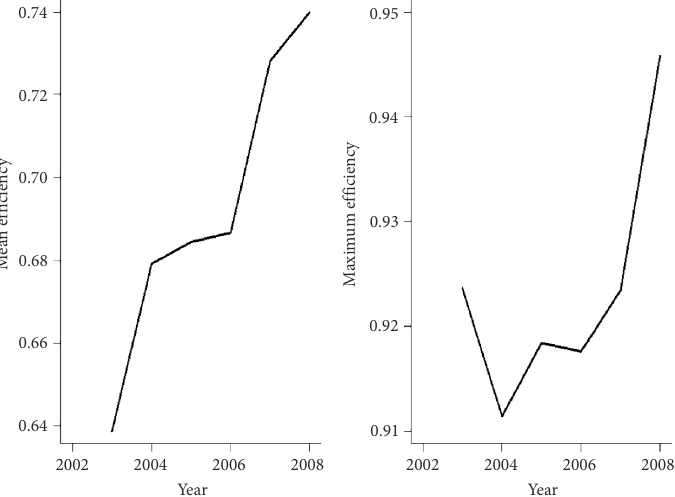
Fig. 4. Trends in mean efficiency and maximum efficiency (2003–2008)